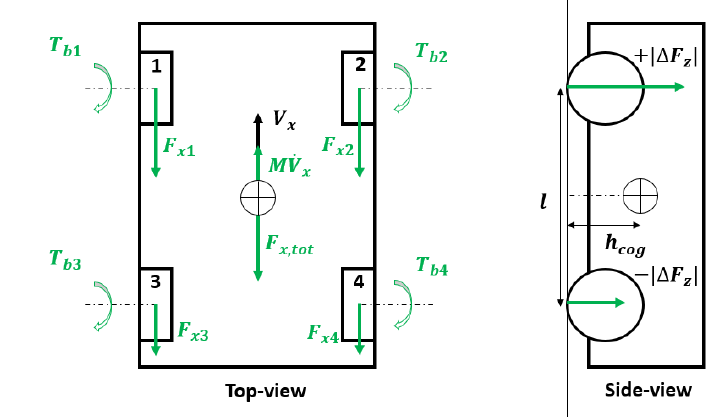
Figure 6. Full-car 5-DoF vehicle model—illustration of forces and